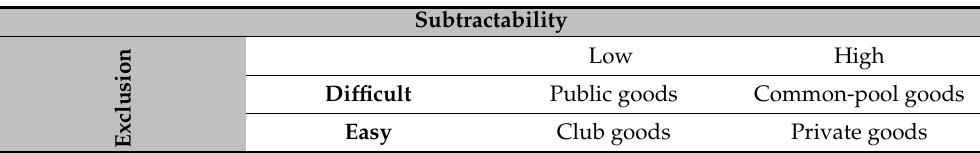
Table 1. Traditional institutional economic classification of goods based on two axes: level of subtractability and difficulty of exclusion. Source: